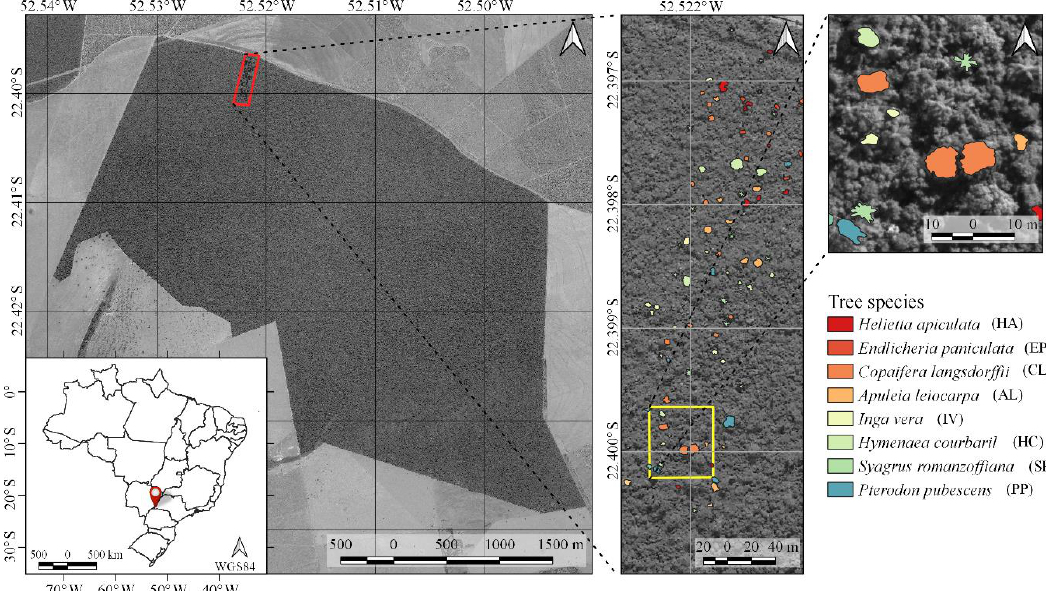
Figure 1. Study area and tree species recognized in the field in the 2017 dataset. The red rectangle represents the imaged area, and the yellow rectangle is a zoom of the study area.